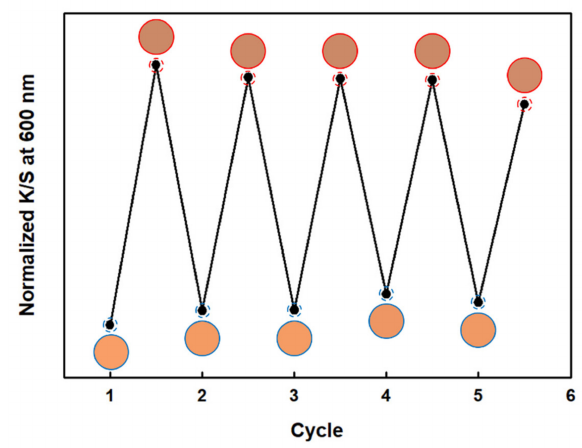
Figure 8. Reversibility of the fabricated textile sensor with NH 3 gas: ( blue circle ) before exposure; ( red circle ) after